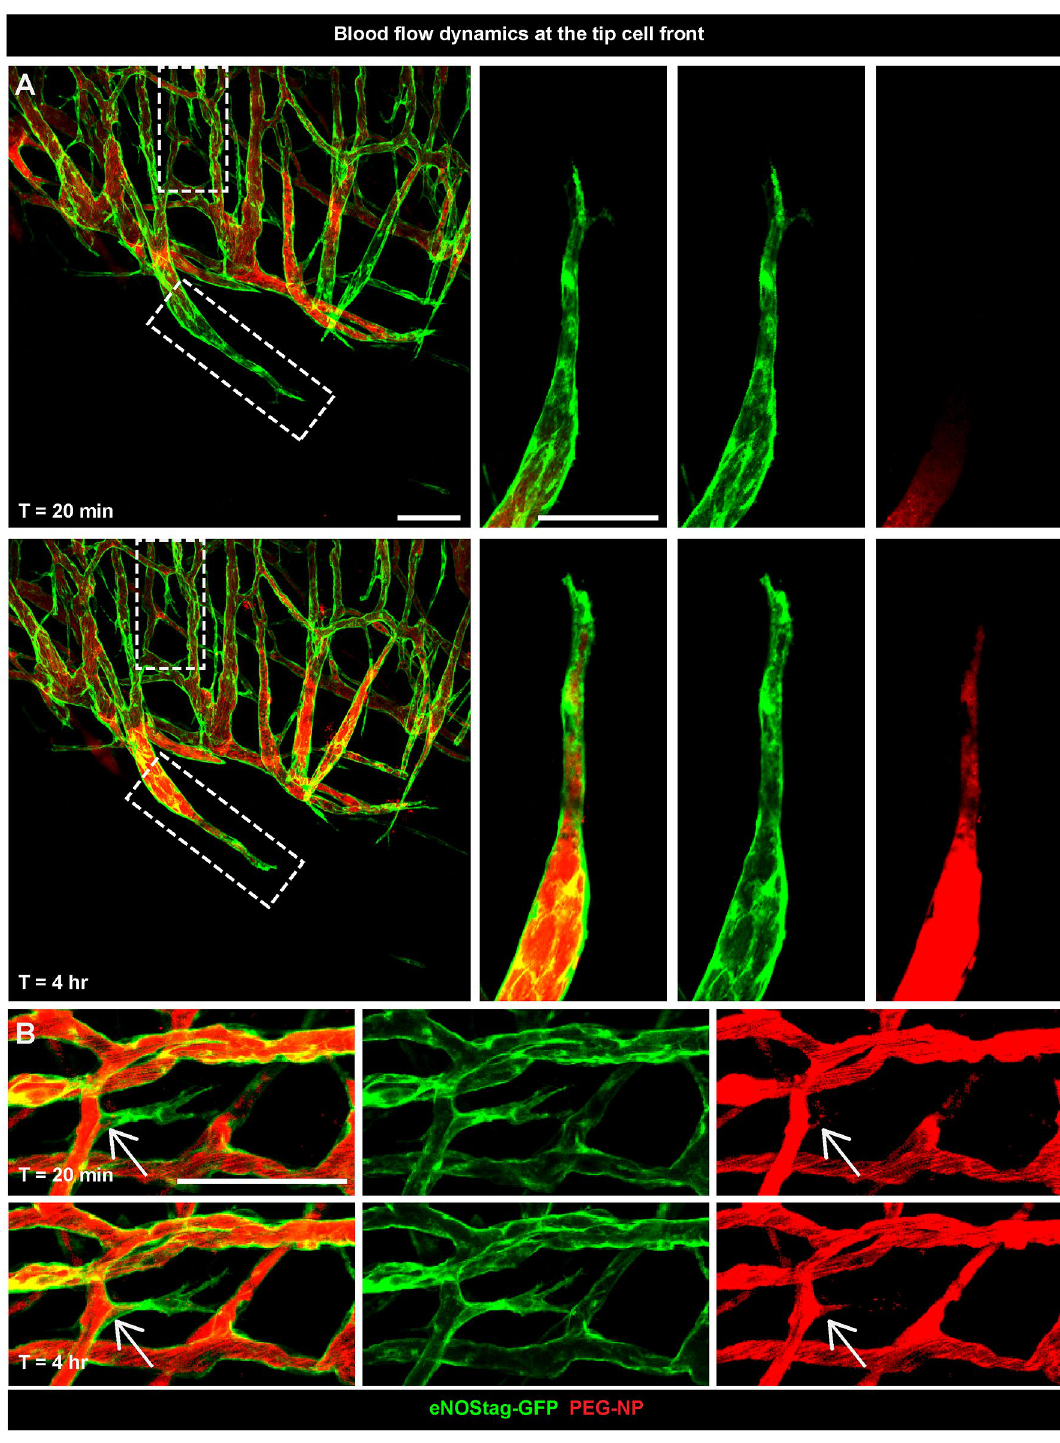
Figure 8. Blood flow dynamics at the tip cell front. Representative 70 µm subsequential maximal projections of endothelial cell (eNOStag-GFP in green) growth in a Lewis lung carcinoma and blood flow (Rhodamine PEGylated nanoparticles in red) 20 min and 4 h after injection of the particles. Scale bar represent 100